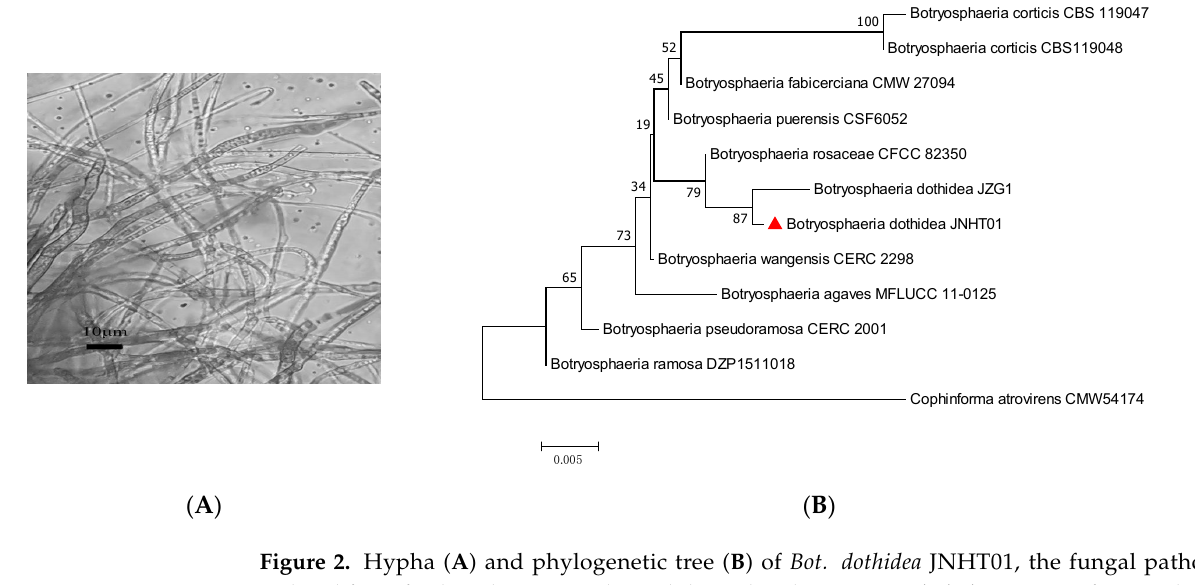
Figure 2. Hypha ( A ) and phylogenetic tree ( B ) of Bot. dothidea JNHT01, the fungal pathogen isolated from fresh walnuts. ▲ indicated the isolated strain Bot. dothidea JNHT01 from walnut in the present study. Table 2. The pathogenicity of Bot. dothidea JNHT01 on fresh walnuts at 5- and 8-day incubation. Incubation Time